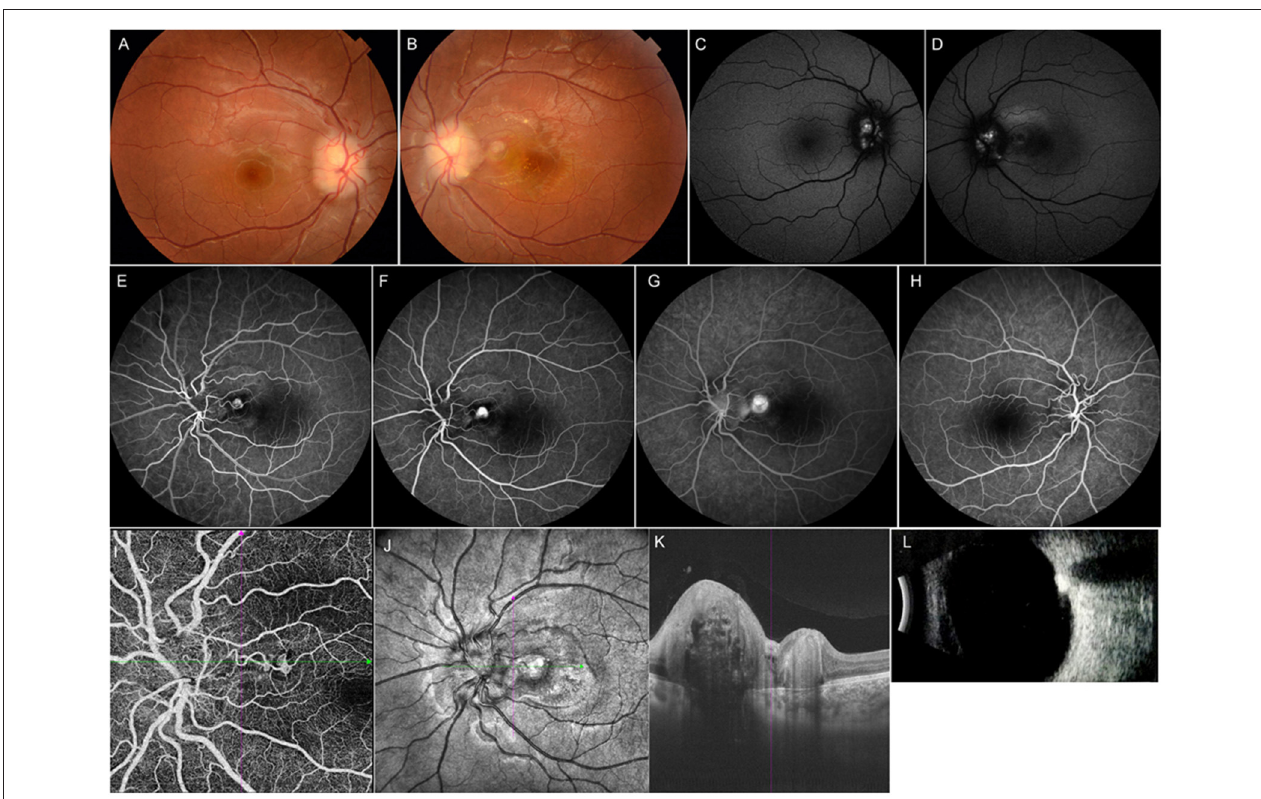
FIGURE 2 | Multimodal imaging of an 11-year-old female with optic disc drusen. Her BCVA was 0.8 logMAR in the left eye and 0.1 logMAR in the right eye. Her ocular and systemic history was unremarkable. (A,B) Fundus photograph showed elevated optic discs with blurred margins in both eyes. (C,D) Mild hyperautofluorescence was observed around the disc bilaterally. (E–G) FFA showed a lesion located in the peripapillary area with hyperfluorescence in the early phase and leakage in the late phase in the left eye. (H) FFA image of the right eye. (I,J) OCT angiography clearly showed CNV located in the peripapillary area. (K) OCT image of the left eye revealed subretinal hyperreflectivity. (L) Ultrasound B-scan showed a strong signal in front of the optic disc. The girl underwent intravitreal ranibizumab treatment, and her BCVA improved to 0.1 logMAR at final